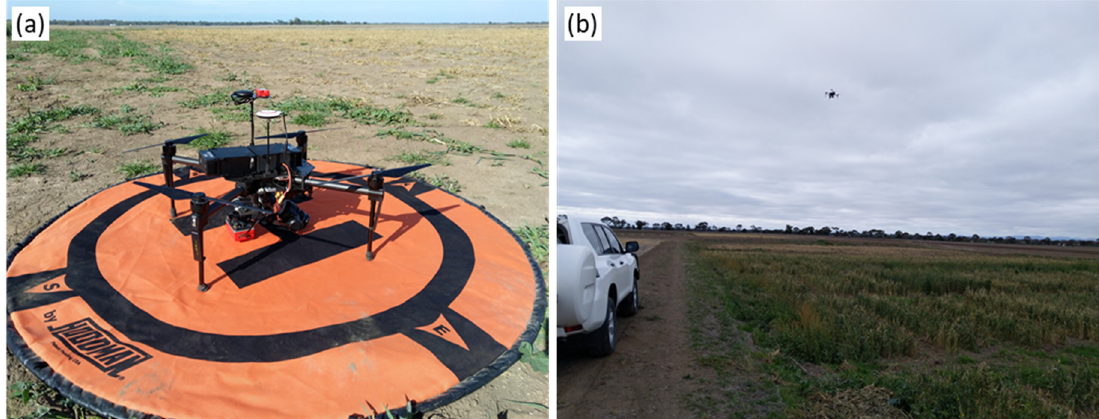
Figure 1. Field high-throughput phenotyping: ( a ) Unmanned aerial vehicle mounted with a RedEdge MicaSense multispectral camera, a global positioning system and downwelling light sensor; ( b ) Aerial mission on a field experiment at Plant Breeding Centre, Horsham, Victoria, Australia.